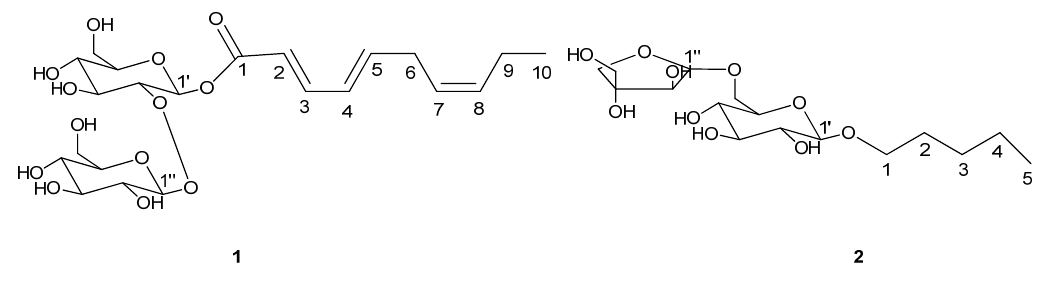
Figure 1. Structures of compounds 1 and 2